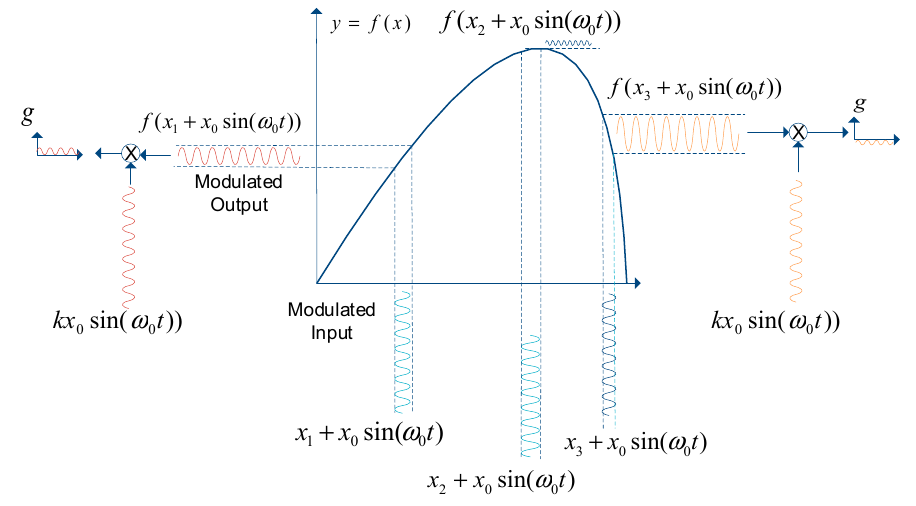
Figure 24. Sinusoidal extremum seeking method.